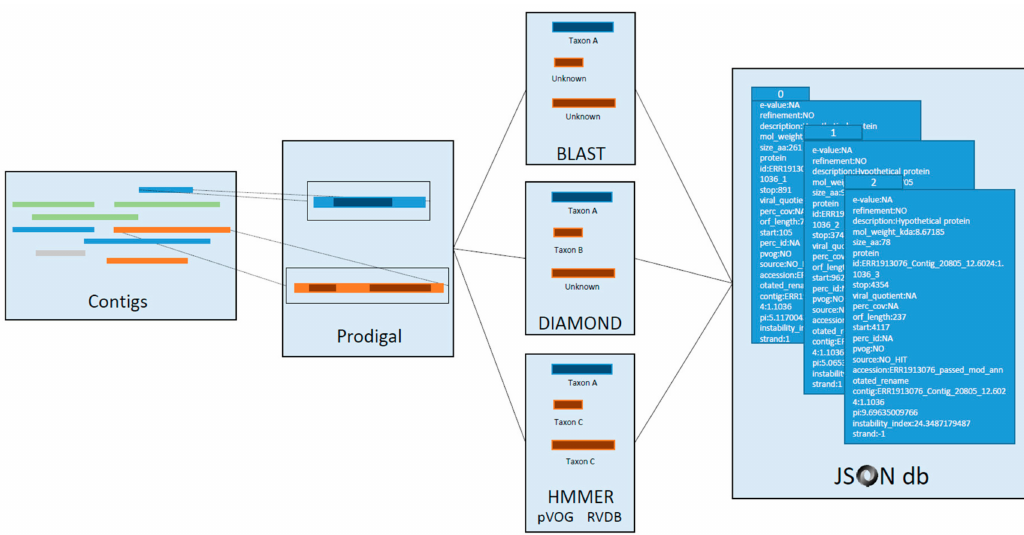
Figure 5. Sequence annotation with VIGA. Putative viral sequences were annotated using the modified VIGA pipeline. Contigs depicting (putative) viral sequences, prefiltered by the presence of a viral CDD, were passed to VIGA. Each contig had their open reading frames (ORF) detected and translated with Prodigal using the 11th genetic code. Each viral protein was further characterized with a combination of three di ff erent annotation methods: BLAST, DIAMOND, and HMMER. HMMER included two model databases: pVOGs (prokaryotic viruses) and RVDB (all viral sequences but prokaryotic viruses). Coordinates, protein translation, hits, E-values, viral quotient, percentage of identity, and other meaningful information are codified in a hierarchical JSON database for downstream analysis.